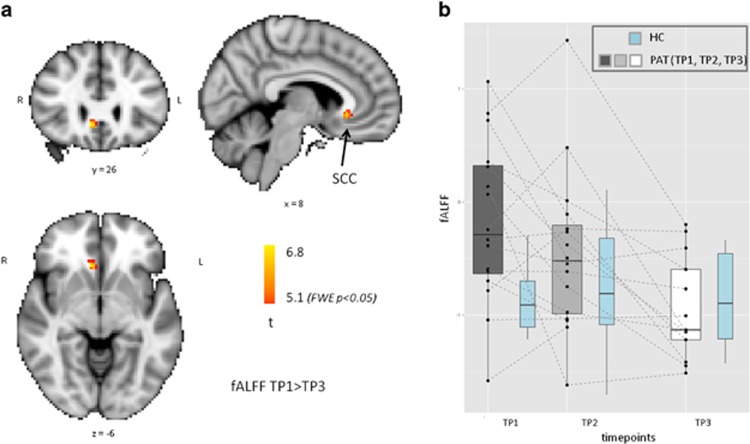
Decreases in fALFF between TP1 to TP3. (a) Voxel-based statistics across whole brain. (b) Post hoc analysis of the primary result including all the three time points from both patients and healthy controls (with blue). These results show that fALFF was higher at baseline in depressed patients, and it was normalized during the course of ECT (see statistics in the text). ECT, electroconvulsive therapy; fALFF, fractional amplitude of low frequency fluctuation; TP, time point.